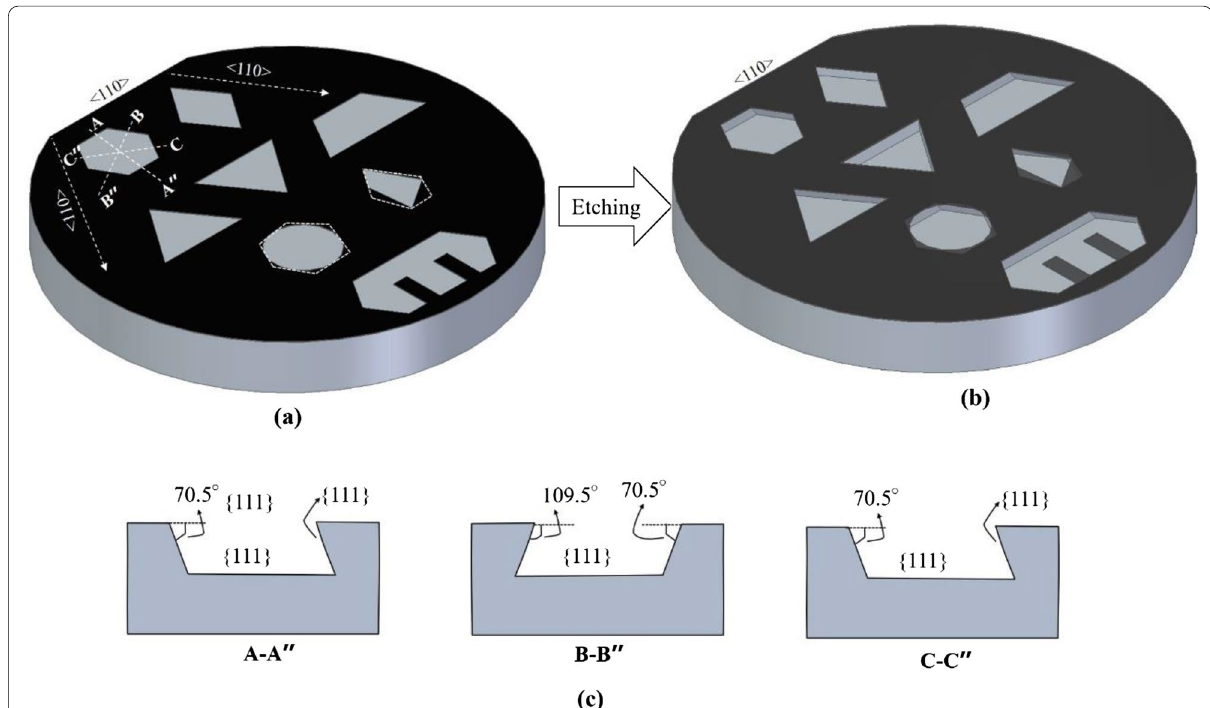
Fig. 3 Schematic demonstration of the wet anisotropically etched profiles of various shapes mask geometries on Si{111} wafer: a mask patterns, b etched profiles after etching in wet anisotropic etchants, and c cross sectional view along different directions. Dashed lines in a show the directions where wet etching will terminate due to the appearance of {111} planes